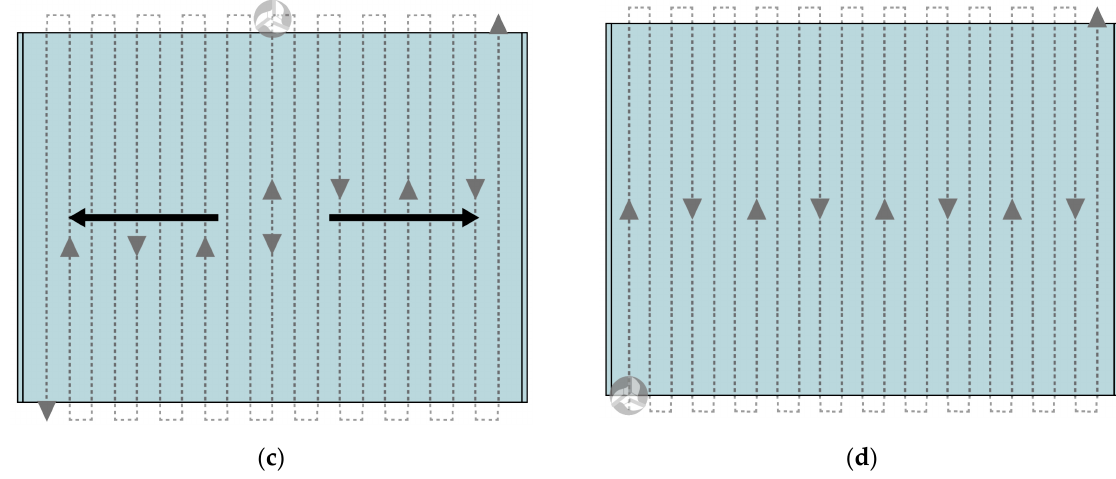
Figure 6. The four toolpaths: ( a ) one-way contour, ( b ) Z-level follow cavity, ( c ) Z-level follow core, and ( d ) rough zigzag.